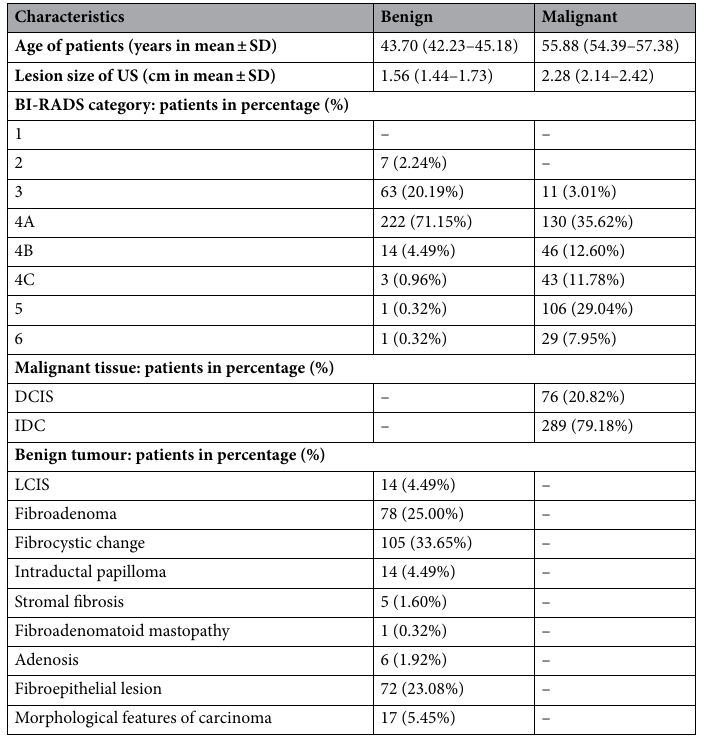
Table 1. Characteristics of all enrolled patients. Basic characteristics of all enrolled patients and the proportions of benign (n = 312) and malignant (n = 365) cases include the age of patients (mean ± SD), size of lesions in the US and the BI-RADS category / benign and malignant tissue of patients. US: ultrasound; DCIS: ductal carcinoma in situ; LCIS: lobular carcinoma in situ; IDC: invasive ductal carcinoma; Morphological features of carcinoma: it showing morphological features of carcinoma in the US image, and confirmed to be benign tissue after a